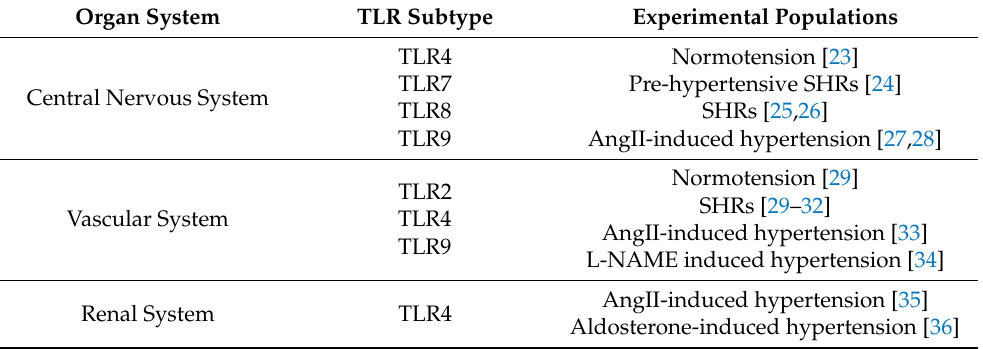
Table 1. Experimental populations where TLR activation has been documented and the relevant subtypes of TLRs involved in the pathogenesis of hypertension according to organ system. Organ System TLR Subtype Experimental Populations Central Nervous System Vascular System Renal System TLR4